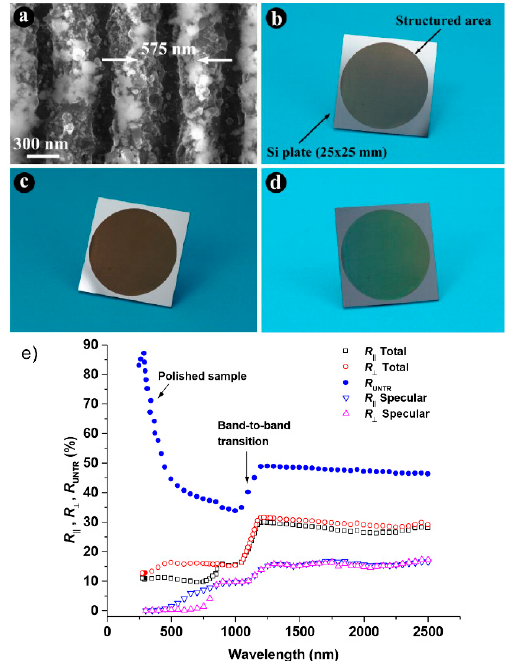
Figure 13. Antireflection effect of LIPSS on silicon: ( a ) SEM micrograph of LIPSS; ( b – d ) photographs of laser structured silicon surfaces reveal various shades of dark colors at different viewing angles; ( e ) spectral and polarization response at an incidence angle of 6° of the structured silicon sample. Adapted from Vorobyev and Guo [92], Copyright 2011, with permission from OSA Publishing.